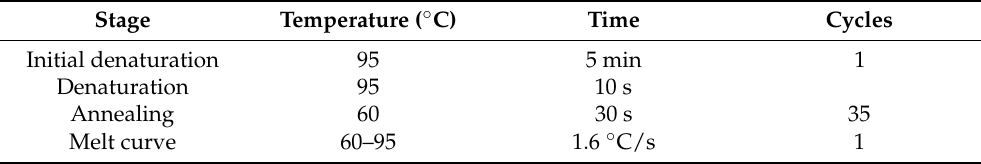
Table 1. Detailed information of amplification method for qPCR in mouse